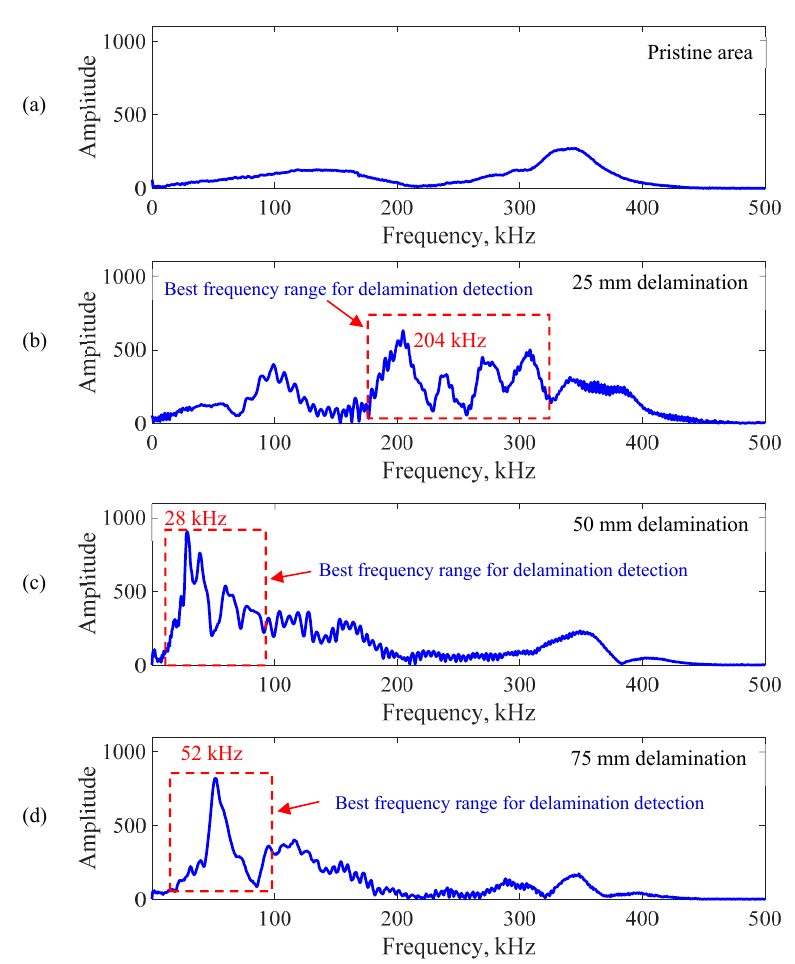
Figure 11. Frequency spectrum of the response signals at the center point of different scanning areas: